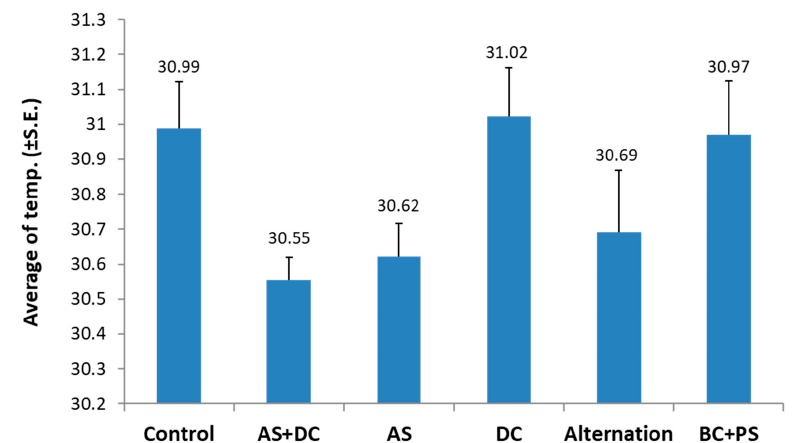
Figure 6. Thermal analysis (Amir, summer 2018). Values indicate an average of 10 repeats. Vertical error bars indicate standard error. No statistical significance between the treatments or between the treatments and the control was found ( p < 0.05,